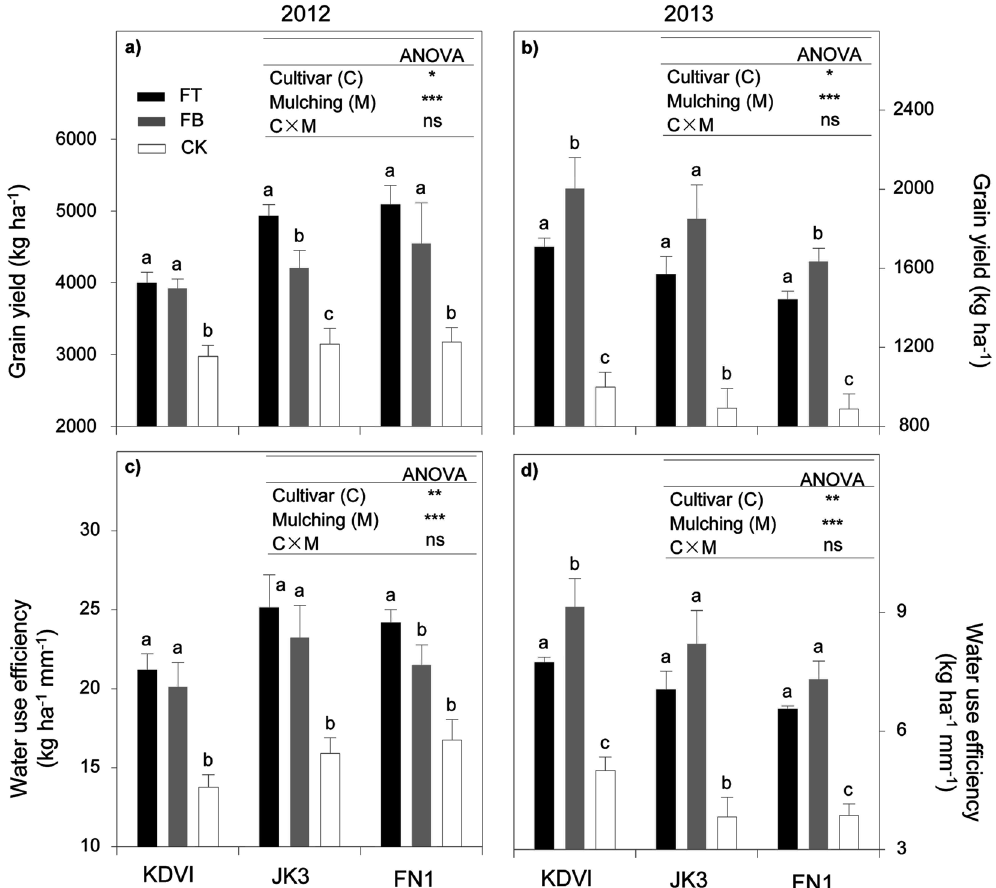
Figure 4. Grain yield and water use efficiency as affected by maize cultivars (early- mid- and late-maturing, KDVI, JK3 and FN1, respectively) and ridge-furrow differing in mulching materials (FT, alternative ridge- furrow with transparent film mulching; FB, alternative ridge-furrow with black film mulching and CK, alternative ridge-furrow with no mulching) in both growing seasons, on a sandy clay loam in Kenya, east African Plateau. Values followed by the same letters in each cultivar are not significantly different at p < 0.05 level. * , ** and *** significant at p < 0.05, 0.01 and 0.001 level, respectively; ns, not